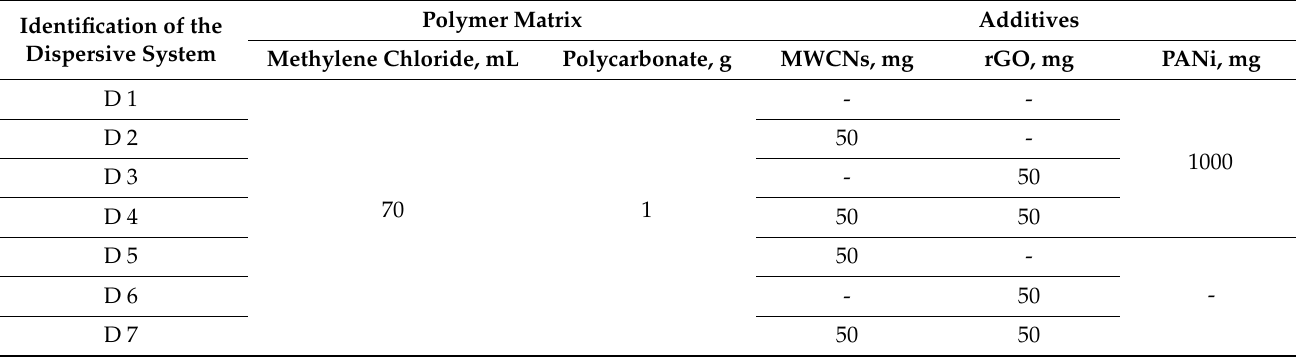
Table 1. Composition of the developed dispersive